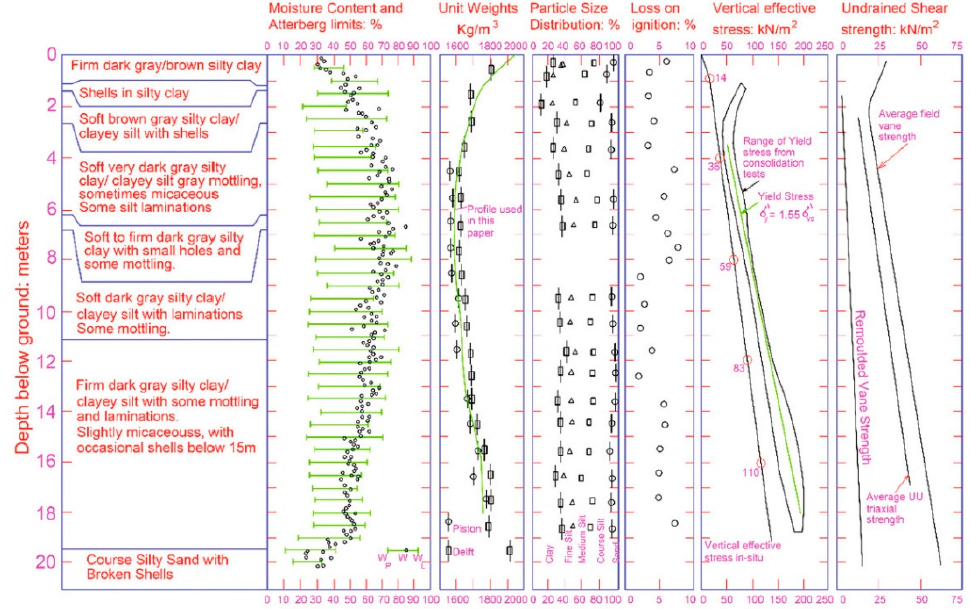
Figure 1. Soil stratigraphy and key soil properties for the Bothkennar site after [38].